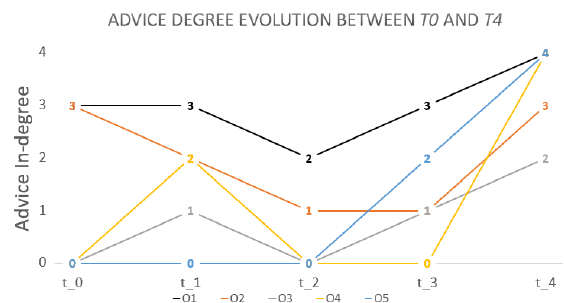
Figure 6. Advice degree evolution between t0 and t4 for project A